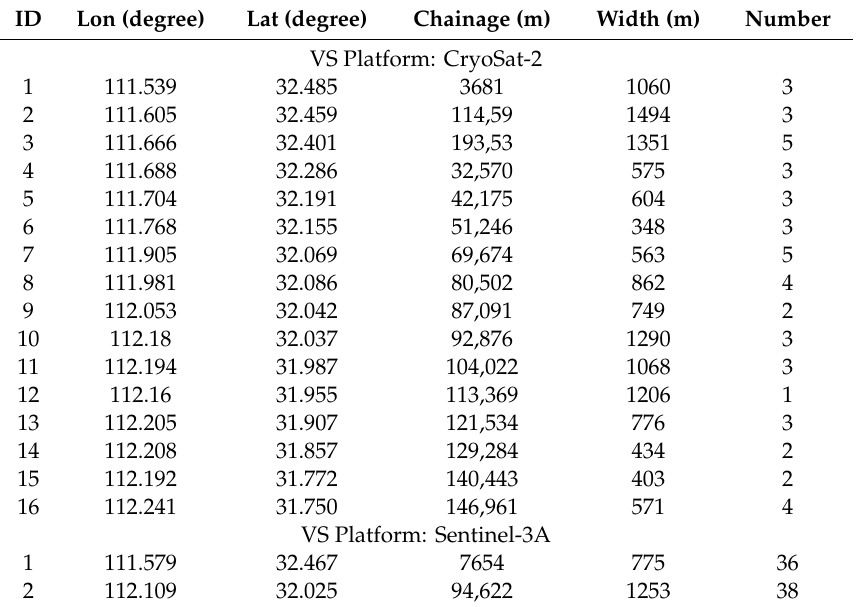
Table 2. Characteristics of each virtual station from the Sentinel-3A and CryoSat-2